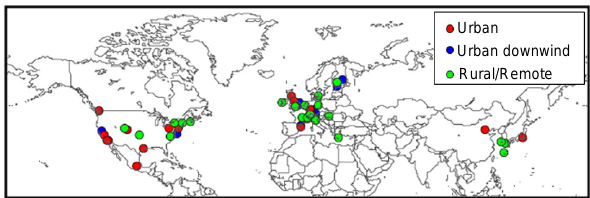
Figure 3. Location of the field measurement campaigns used for evaluating the model during 2001–2010. Urban, urban downwind and rural/remote areas are represented by red, blue, and green col- ors,